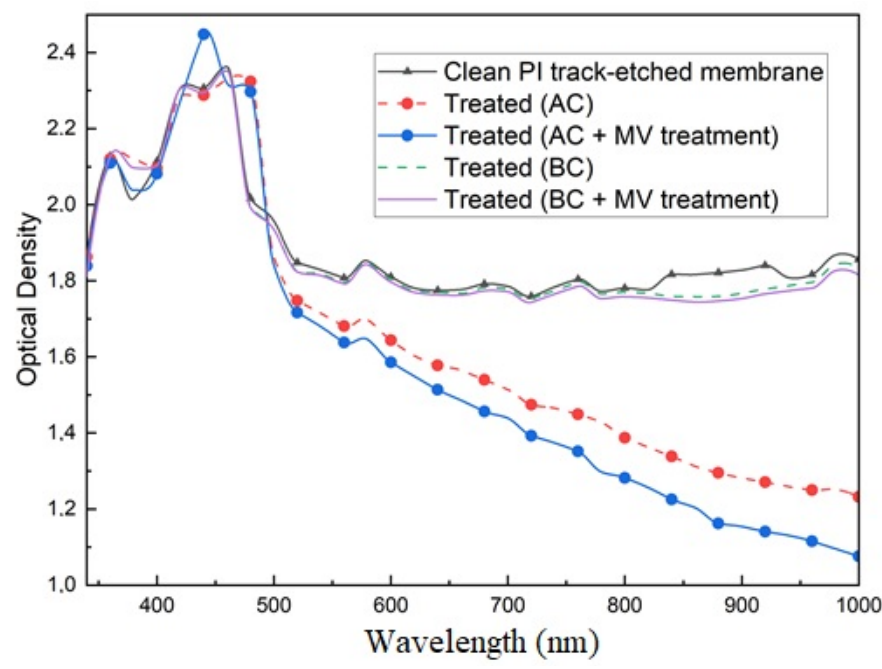
Figure 2. Changes in the optical density index of track membranes when treated with products: AC—hydrolysis with acid catalyst; AC + MV treatment—hydrolysis with acid catalyst followed by microwave treatment; BC—Hydrolysis with base catalyst; BC + MV treatment—hydrolysis with base catalyst followed by microwave treatment .